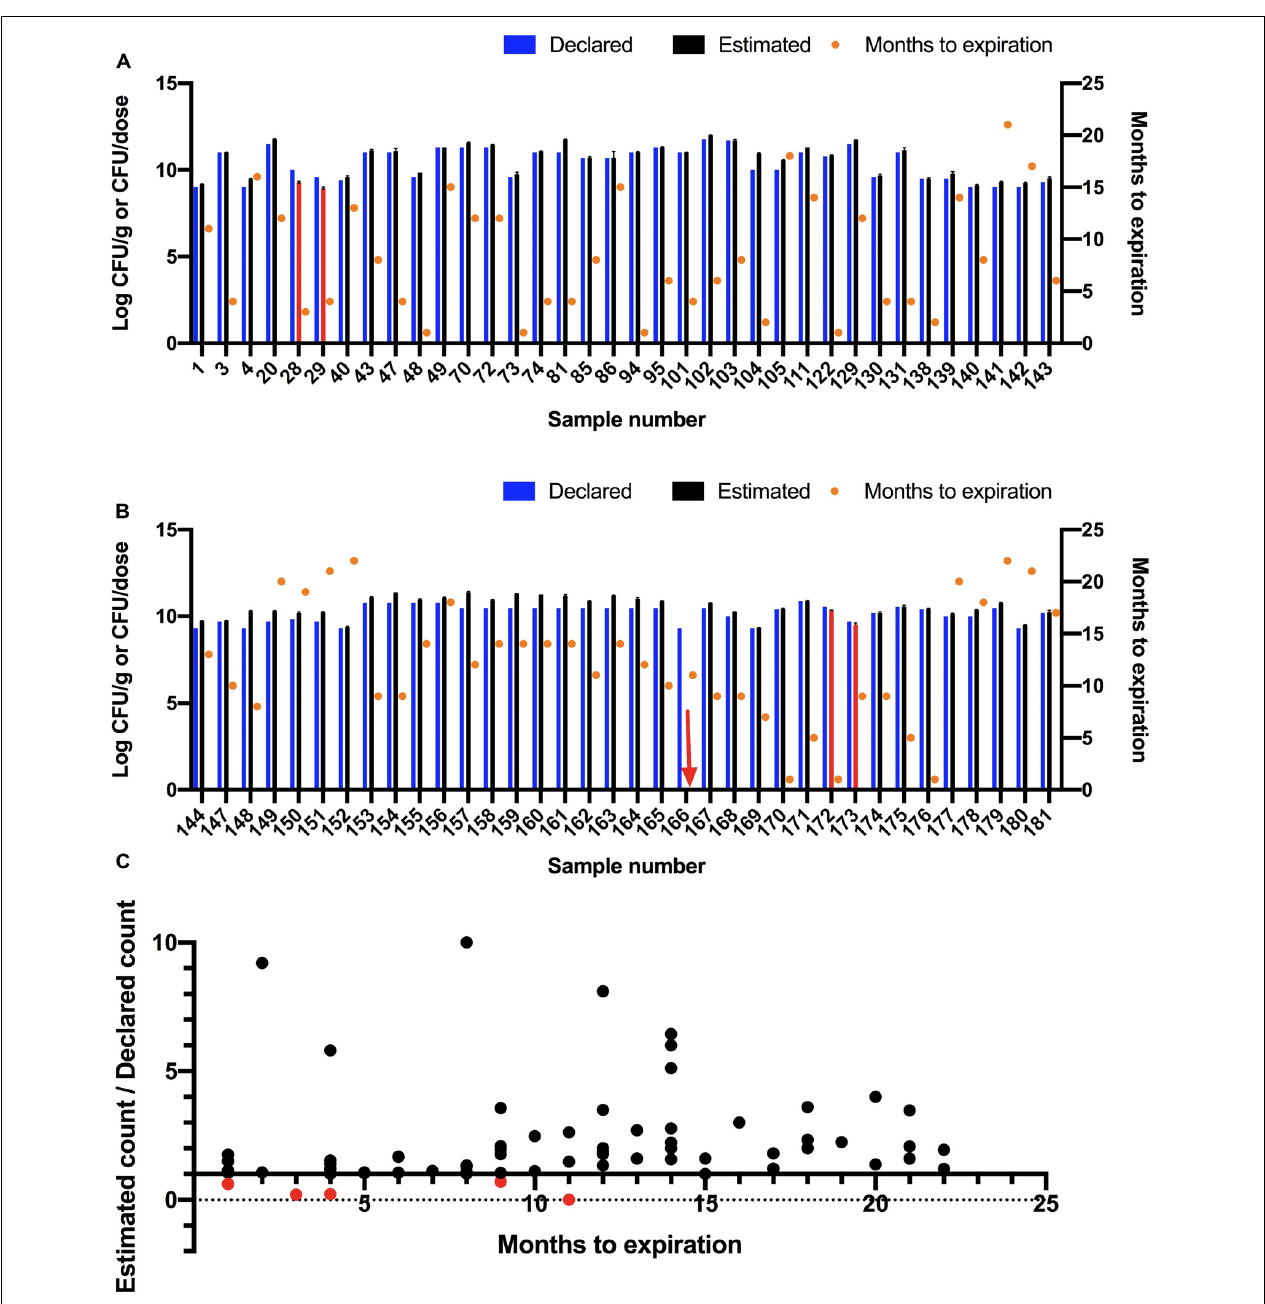
FIGURE 4 | Estimating colony-forming units (CFU) of probiotic samples using a plate culture method. (A,B) Declared and estimated viable count where Log 10 estimated CFU/g or CFU/dose are shown on left Y -axis as the mean of three replicates with Standard Error of Mean (SEM). The bars are shown in red for samples that did not meet the declared viable counts. The red arrow indicates a sample that did not show any viable count. The declared viable counts are shown as blue bars. Time to expiration in months is shown on right Y -axis (orange circles). Samples are split into two graphs for ease of readability. (C) Ratio of estimated viable count to declared viable count compared to months to expiration at time of